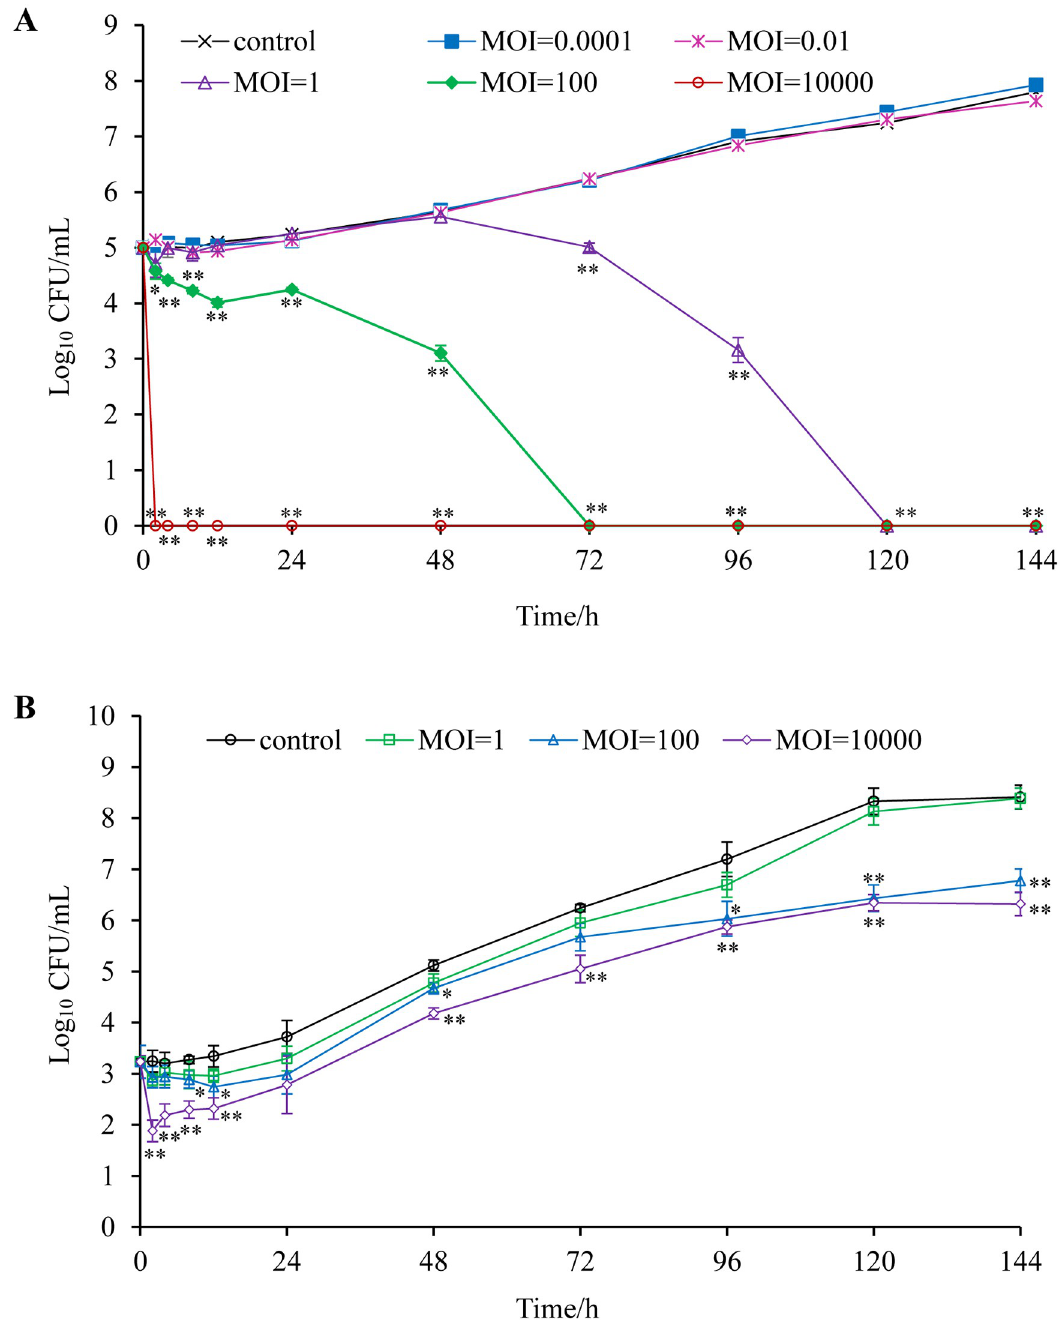
Fig 6. Phage PSDA-2 control of S .Typhimurium with different MOI. (A) In LB. (B) In chilled mutton. �� , P < 0.01, � , P < 0.05, compared to the control samples at the same time point by one-way ANOVA test.